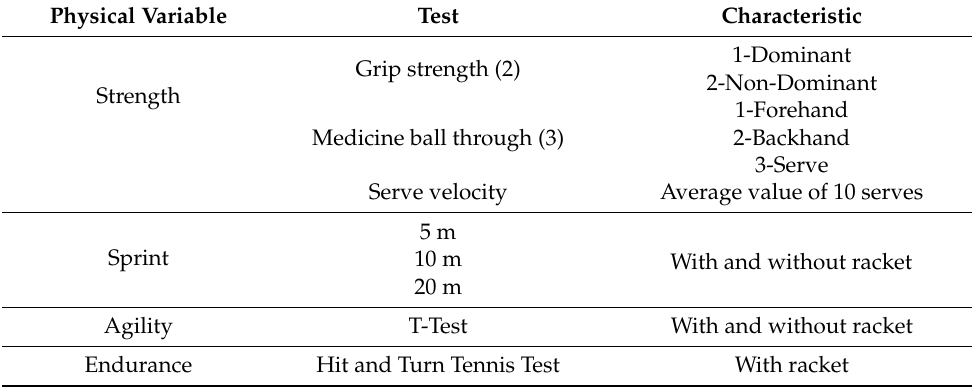
Figure 3. Medicine ball through backhand ( a ), forehand ( b ), and serve ( c ). Table 2 shows the physical variables measured as well as the different tests used. Table 2. Physical variable and test